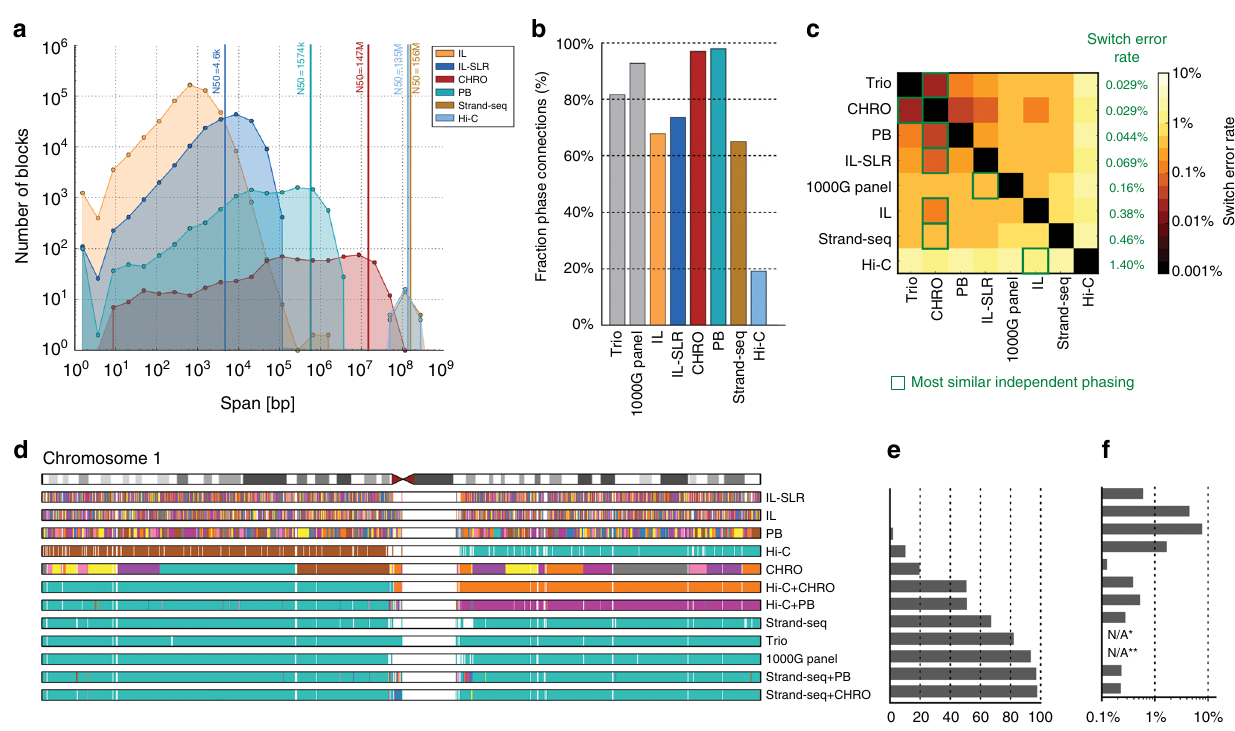
Fig. 1 Characteristics of SNV-based haplotypes obtained from different data sources. a Distribution of phased block lengths for the YRI child NA19240. Note that Strand-seq haplotypes span whole chromosomes and therefore one block per chromosome is shown. Vertical bars highlight N50 haplotype length: the minimum length haplotype block at which at least half of the phased bases are contained. For Illumina (IL) paired-end data, phased blocks cover <50% of the genome and hence the N50 cannot be computed. b Fraction of phase connection, i.e., pairs of consecutive heterozygous variants provided by each technology (averaged over all proband samples). c Pairwise comparisons of different phasings; colors encode switch error rates (averaged over all proband samples). For each row, a green box indicates the phasing of an independent technology with best agreement, with corresponding switch error rates given in green. d Each phased block is shown in a different color. The largest block is shown in cyan, i.e., all cyan regions belong to one block, even though interspaced by white areas (genomic regions where no variants are phased) or disconnected small blocks (different colors). e Fraction of heterozygous SNVs in the largest block shown in d . f Mismatch error rate of largest block compared to trio-based phasing, averaged over all chromosomes of all proband genomes (i.e., the empirical probability that any two heterozygous variants on a chromosome are phased correctly with respect to each other, in contrast to the switch error rate, which relays the probability that any two adjacent heterozygous variants are phased correctly). (*) Not available because trio phasing is used as reference for comparisons. (**) Not shown as population-based phasing does not output block boundaries; refer to Supplementary Material for an illustration of errors in population-based